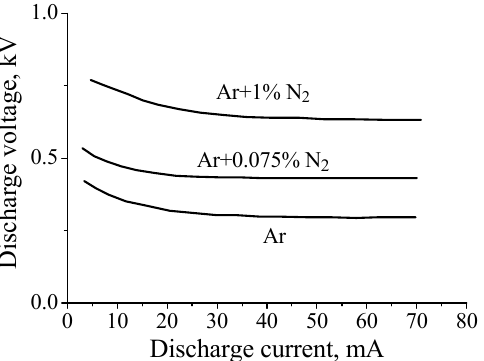
Figure 1. Current–voltage characteristic of discharges in pure argon and the Ar/N 2 mixtures at gas pressure P = 2 Torr [33].